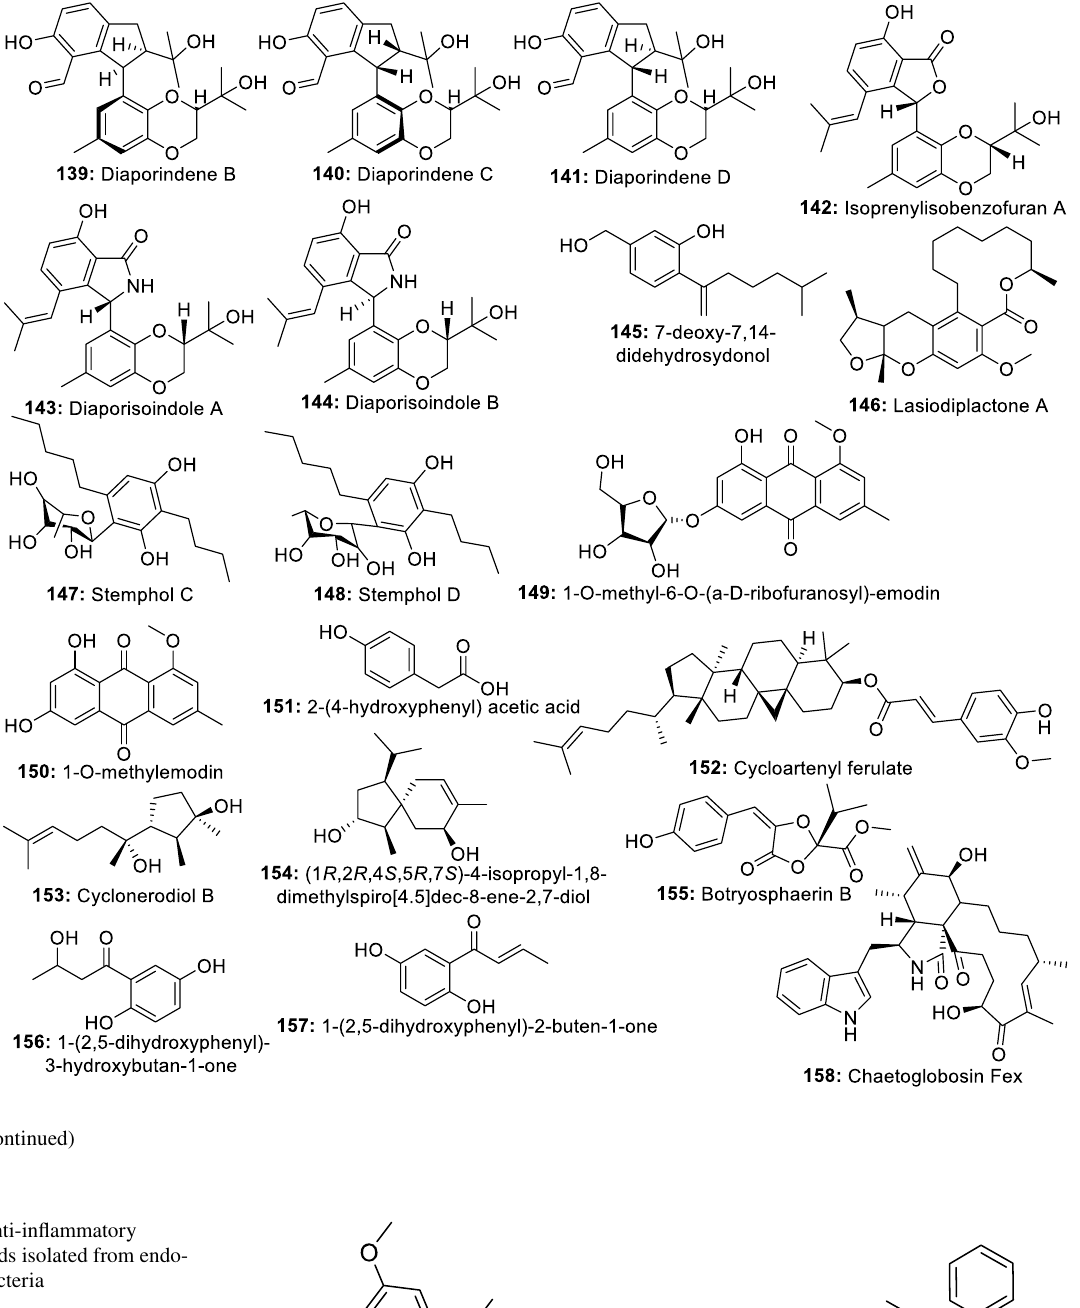
compounds isolated from endo- phytic